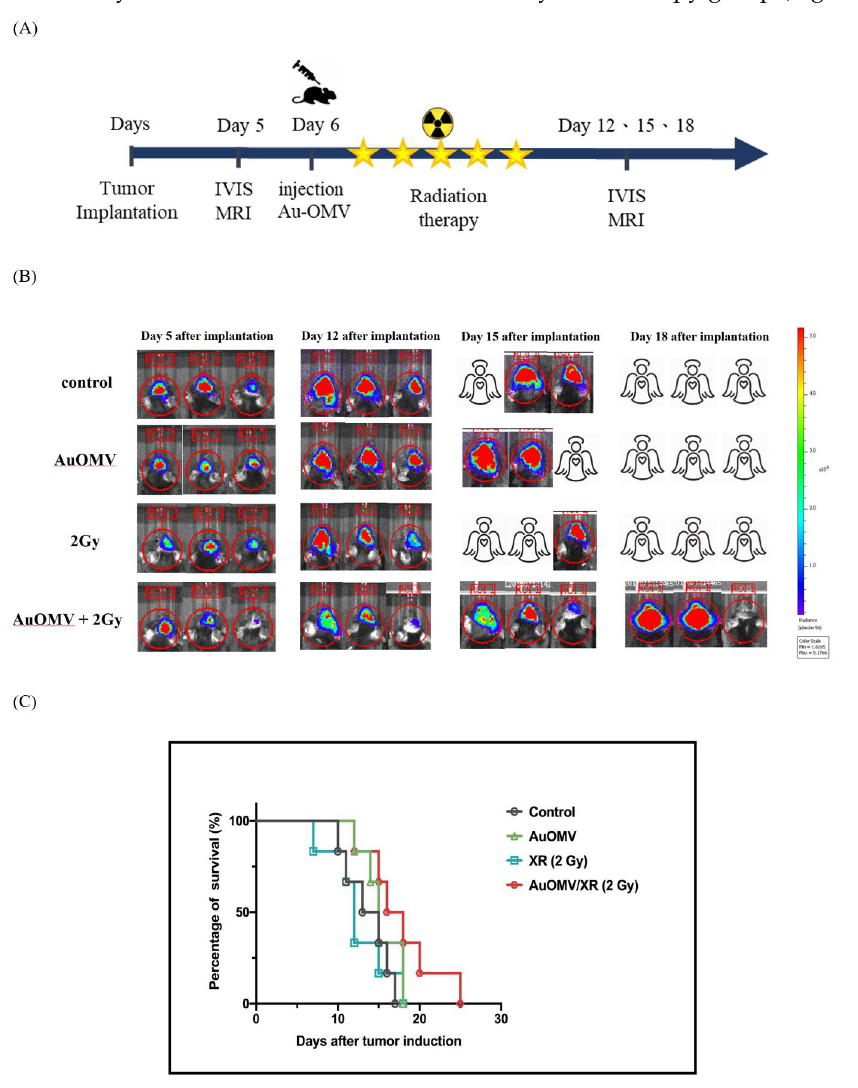
Figure 9. ( A ) Schematic diagram of intracranial Au–OMV injection with radiation therapy for GL261 glioma tumor-bearing mice. ( B ) Assessment of the IVIS imaging system as a method for monitoring tumor growth in a GL261 in situ tumor mode. IVIS imaging of mouse brain tumors on days 5, 12, 15, and 18 after implantation of tumor cells; imaging results of three mice in each group. All images were at the same scale. ( C ) Kaplan–Meier survival curves of control and treatment groups (N > 5 per